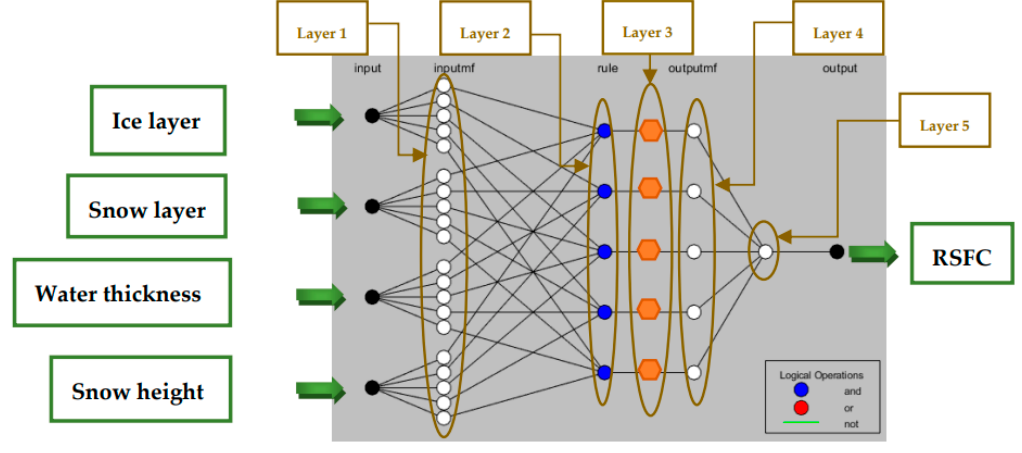
Table 4. ANFIS network information used in this study.